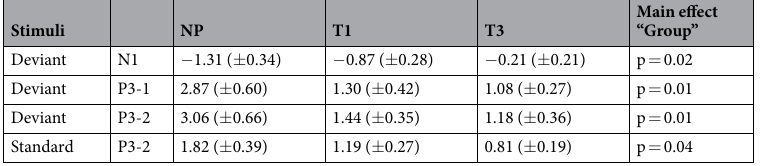
Table 2. CSERP-amplitudes of non-pregnant women, women in their first, and women in their third trimester of pregnancy. Notes: Amplitudes are given as mean values ( ± SEM) in µ V; NP = non-pregnant women, T1 = women in their first trimester of pregnancy, T3 = women in their third trimester of pregnancy.